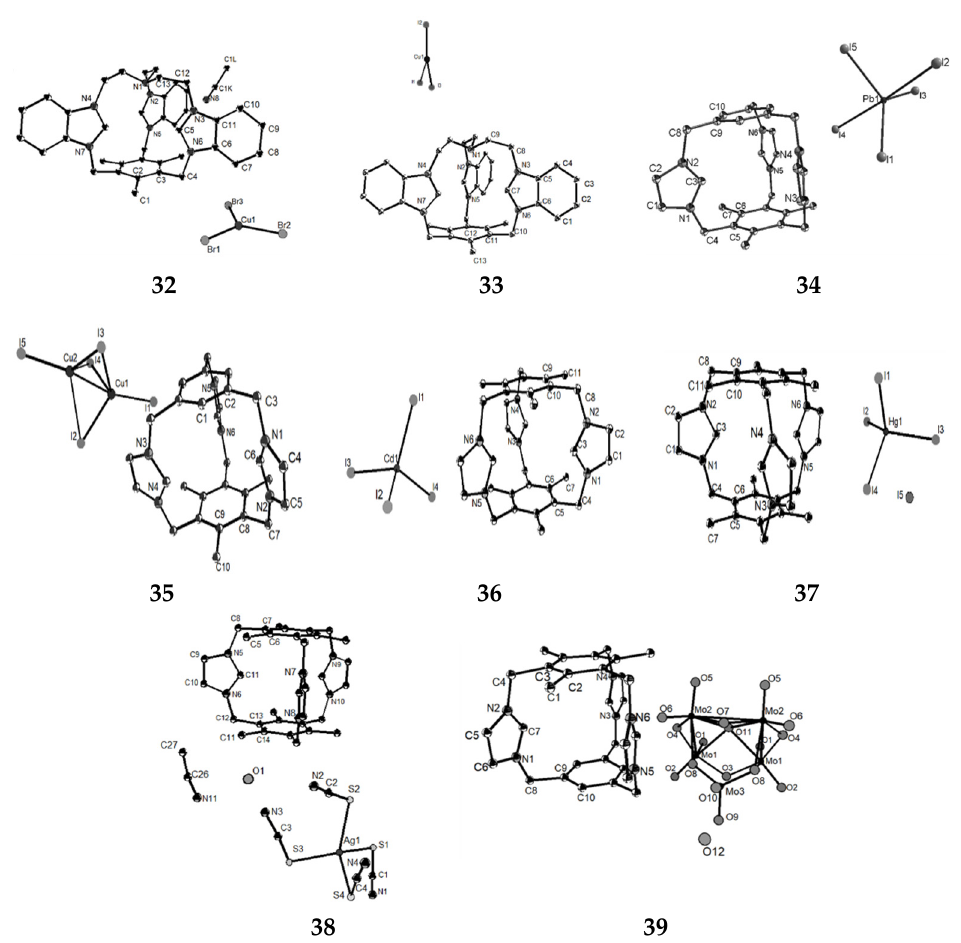
Figure 17. ORTEP drawings of cages 29 , 30 and 31 (the probability of thermal ellipsoid is 50%).